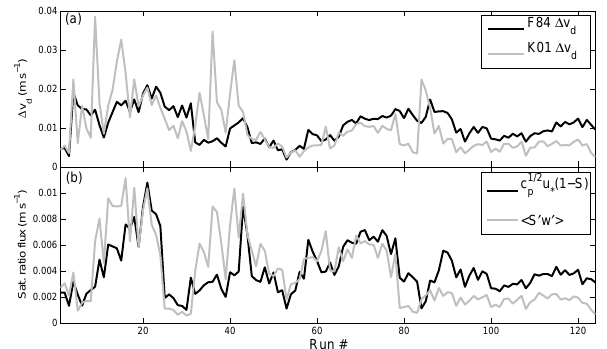
Fig. 5. (a) Run-by-run comparison of K01 and F84 methods for calculating bias velocity, 1v d ; (b) Run-by-run comparison of satu- ration ratio flux and the F84 approximation to